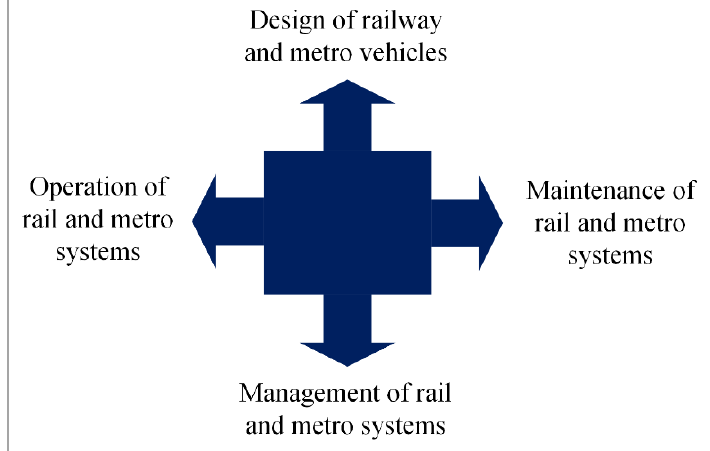
Figure 1. Main areas of the Rail and Metro Engineering course at